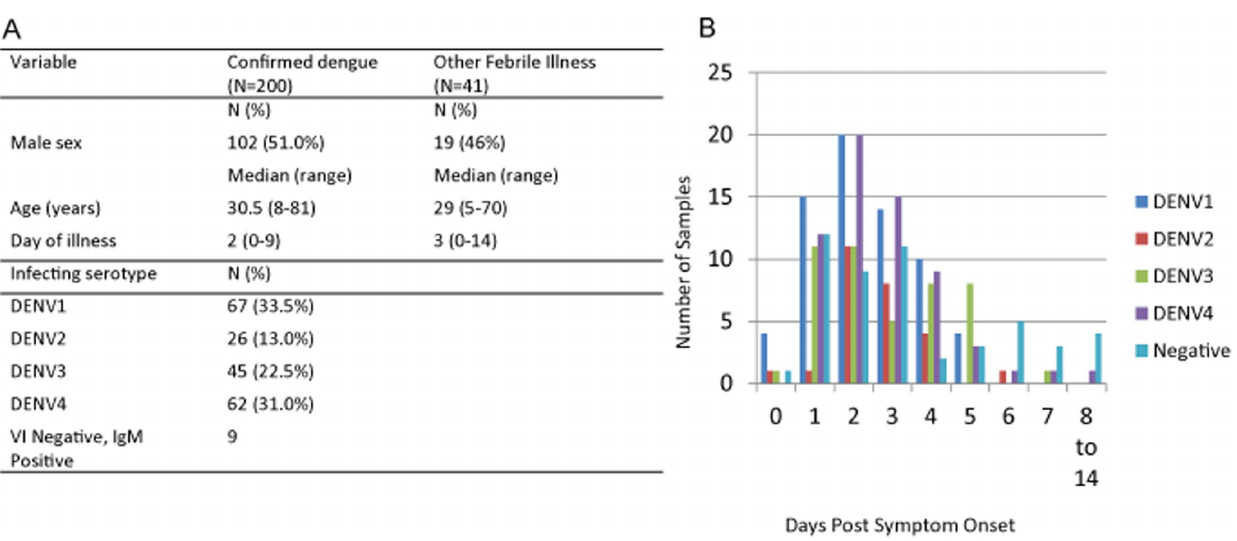
Figure 1. Characteristics of clinical samples used in this study. A. Sex, age, day of illness, and infecting serotype for subjects. B. A plot of the number of samples for a given infecting serotype of DENV graphed over day post symptom onset.